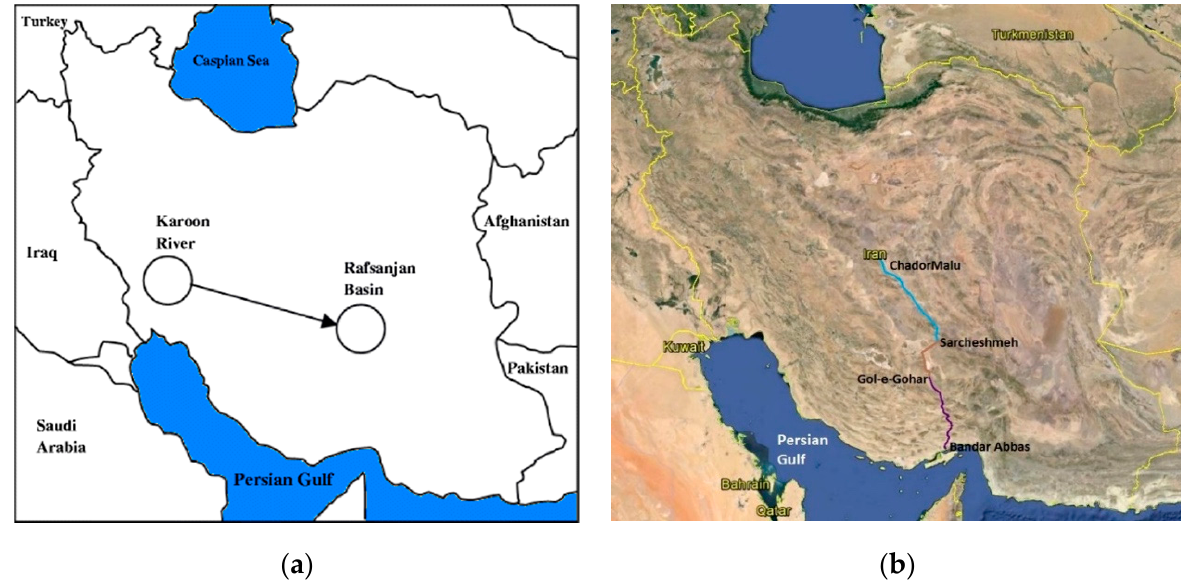
Figure 3. ( a ) The map of Iran indicating the route of transferring water from Karoon to Rafsanjan; ( b ) The route of transferring water from Oman to Sarcheshmeh.